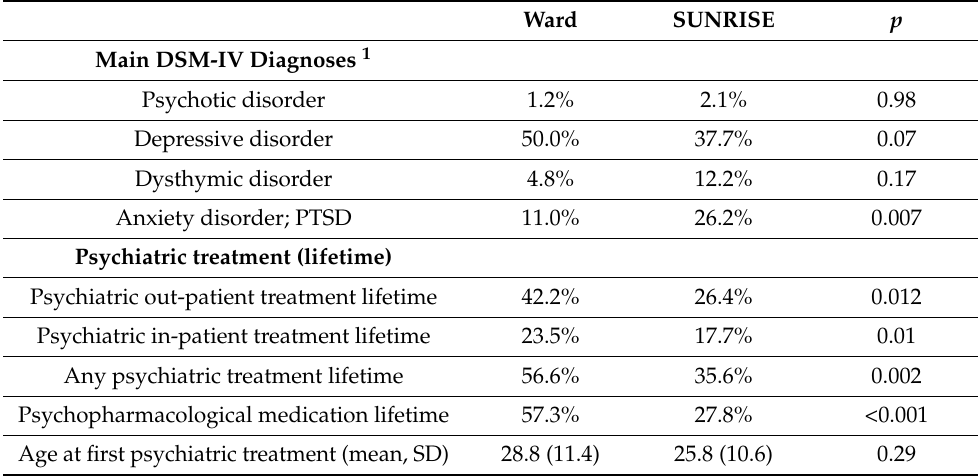
Table 4. Current comorbid mental disorders and history of psychiatric treatment; comparison between clinical sample (inpatient ward) and unemployment office sample